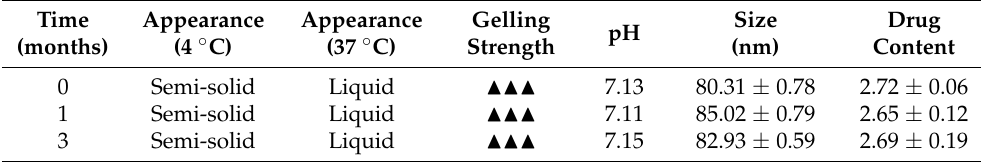
Table 2. Changes in IPC-DNV-TSG after storage ( n = 3).